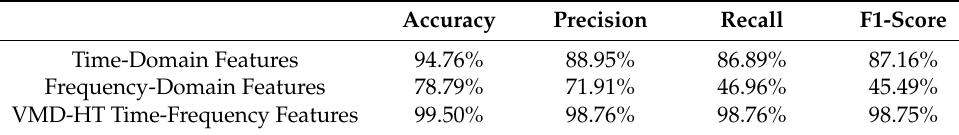
Table 2. Comprehensive classification performance of different domain features.